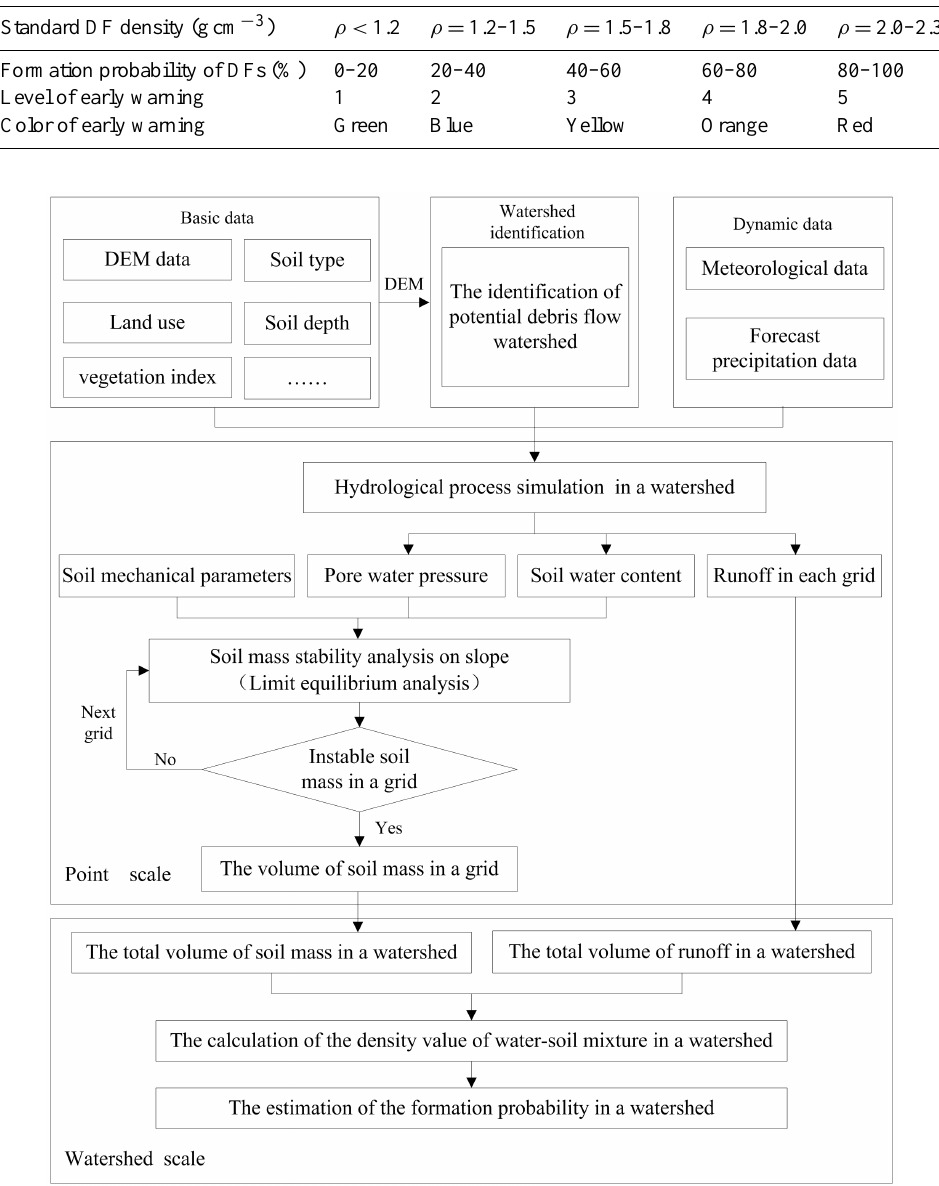
Figure 4. Prediction process of the debris-flow prediction system based on water–soil coupling